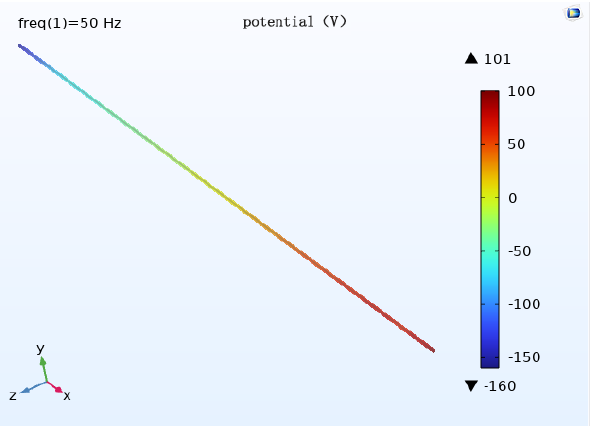
Figure 19. Transmission line to ground height of 38 m when the pipeline cathodic protection potential is distributed .